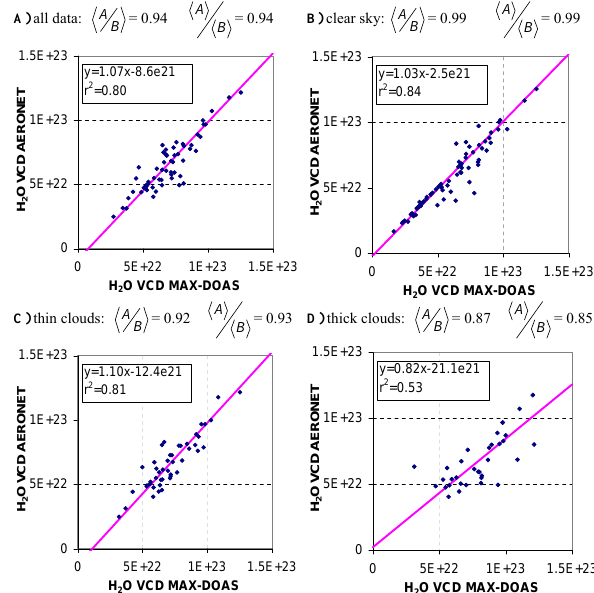
Fig. 15 Correlation analyses of daily average H 2 O VCDs from MAX-DOAS and AERONET Fig. 14 Correlation analyses of daily average H 2 O VCDs from MAX-DOAS and ECMWF data. A) All MAX-DOAS data. B) MAX-DOAS observations for clear sky. C) MAX-DOAS data. A) All MAX-DOAS data. B) MAX-DOAS observations for clear sky. C) MAX-DOAS Fig. 15. Correlation analyses of daily average H 2 O VCDs from Fig. 14. Correlation analyses of daily average H 2 O VCDs from observations for thin clouds. D) MAX-DOAS observations for thick clouds. The symbols observations for thin clouds. D) MAX-DOAS observations for thick clouds. ECMWF are MAX-DOAS and AERONET data. (A) All MAX-DOAS data. (B) MAX-DOAS and ECMWF data. (A) All MAX-DOAS data. (B) BA and BA indicate the average of ratios of individual data pairs and ratio of averages during daytime (6:00, 12:00, 18:00). The symbols BA and BA indicate the MAX-DOAS observations for clear sky. (C) MAX-DOAS obser- MAX-DOAS observations for clear sky. (C) MAX-DOAS obser- averages, respectively. All values in units of molec/cm². average of ratios of individual data pairs and ratio of averages, respectively. All values in vations for thin clouds. (D) MAX-DOAS observations for thick vations for thin clouds. (D) MAX-DOAS observations for thick units of molec/cm². i and h A i clouds. The symbols h A clouds. ECMWF data are averages during daytime (06:00, 12:00, h B i indicate the average of ratios of B individual data pairs and ratio of averages, respectively. All values i and h A i 18:00). The symbols h A h B i indicate the average of ratios of B in units of moleccm − 2 individual data pairs and ratio of averages, respectively. All values in units of moleccm − 2 .